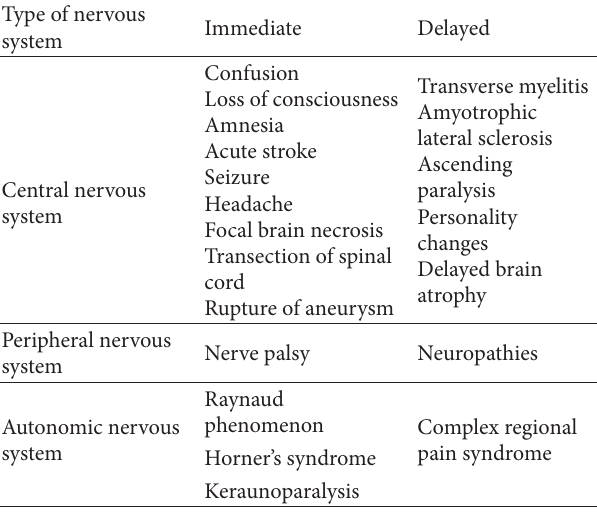
Table 1: Neurological injuries caused by